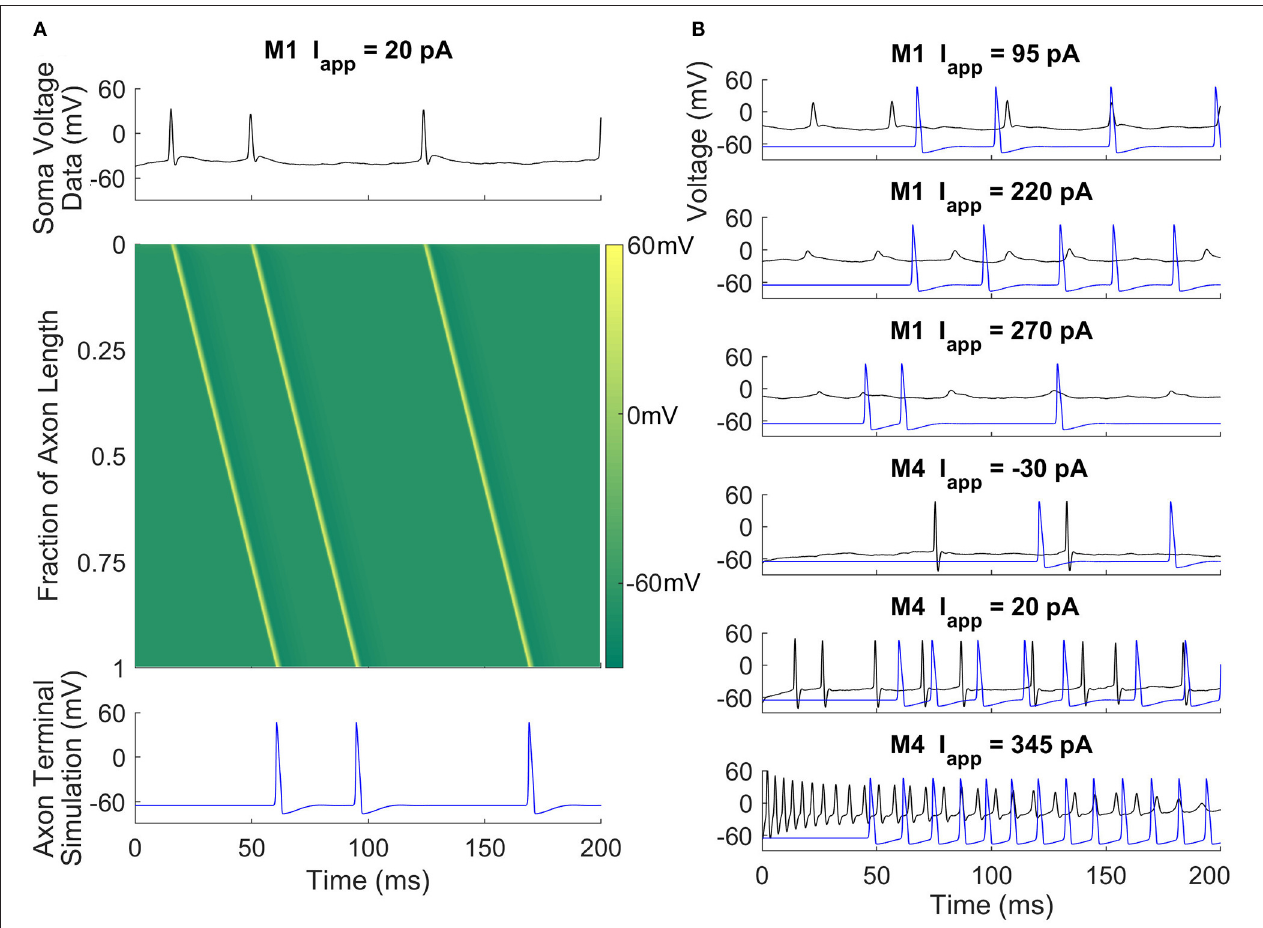
FIGURE 3 | Axonal action potential propagation in M1 and M4 ipRGCs. (A) A space-time colored contour plot (middle) showing the propagation of action potentials in the RHT given input taken from a current-clamp recording of an M1 cell (top) and the simulated output at the axon terminal (bottom). There is an approximate 45ms propagation delay along the axon. (B) Recorded soma voltage (black) and predicted voltage near the axon terminal (blue) for M1 and M4 cells at three different current-clamp values. The simulation suggests that M1 cells can signal to the SCN despite experiencing depolarization block or attenuated action potentials in the